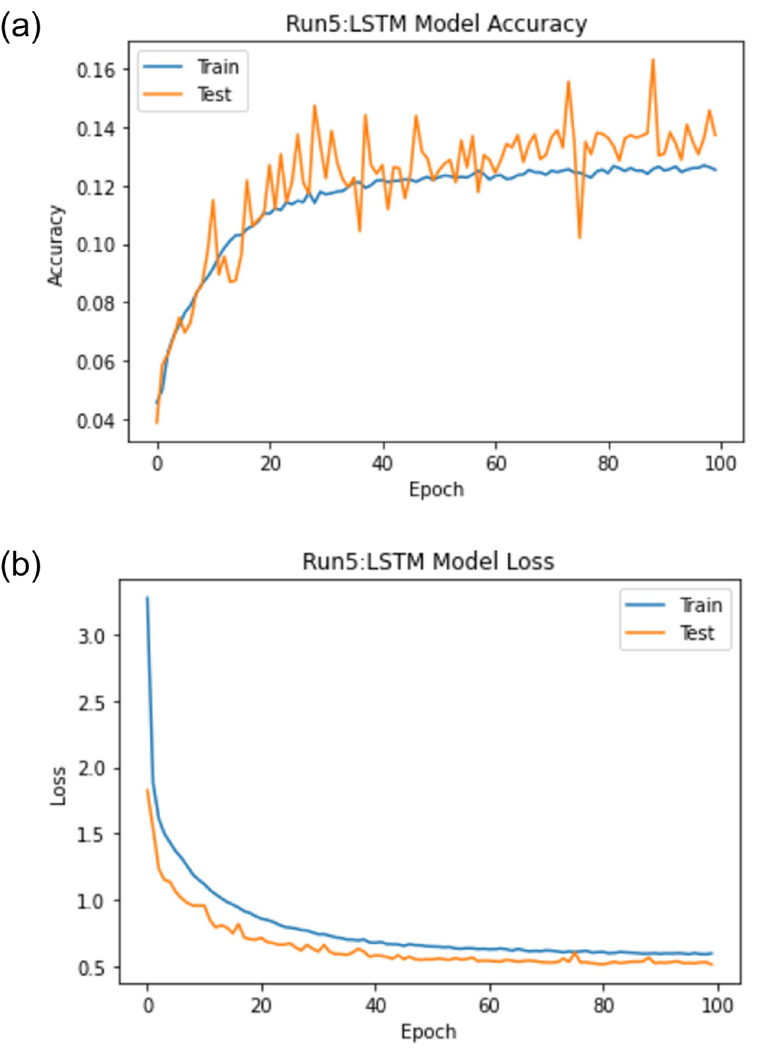
Fig 18. The LSTM-GWO accuracy and loss with experiment